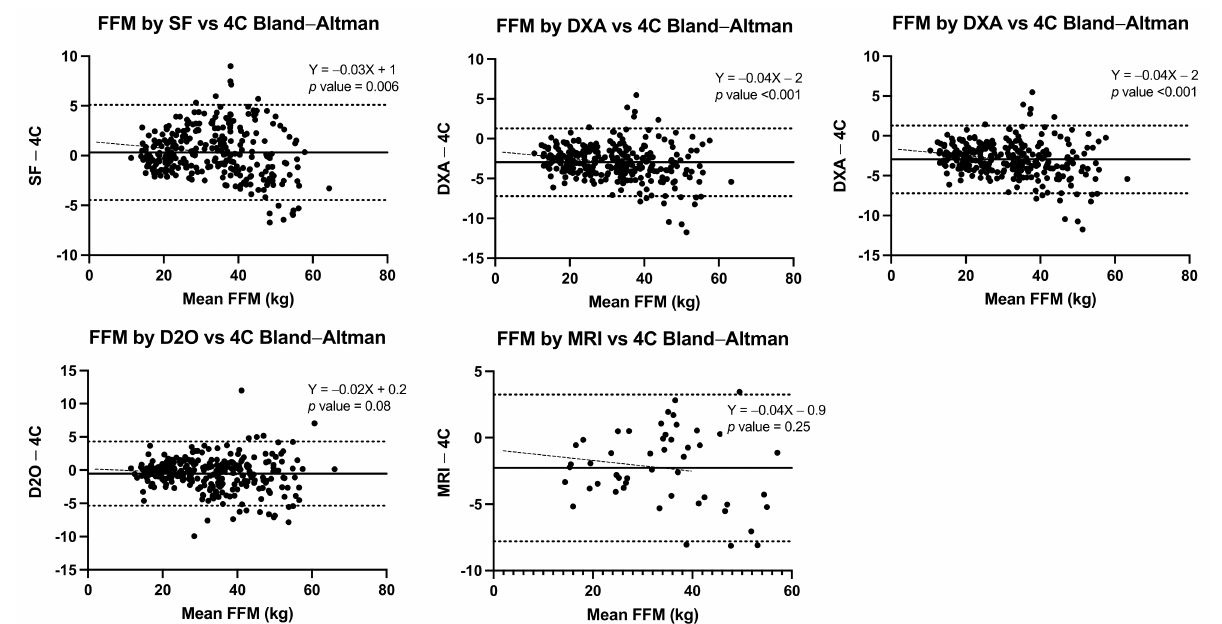
Figure 2. Bland–Altman plots for FFM estimation by SF, DXA, ADP and D 2 O in contrast with the 4-C model for all ages and sex groups. A positive trend indicates an increasing underestimation of FFM at high FFM levels; a negative trend indicates an increasing overestimation of FFM at high FFM